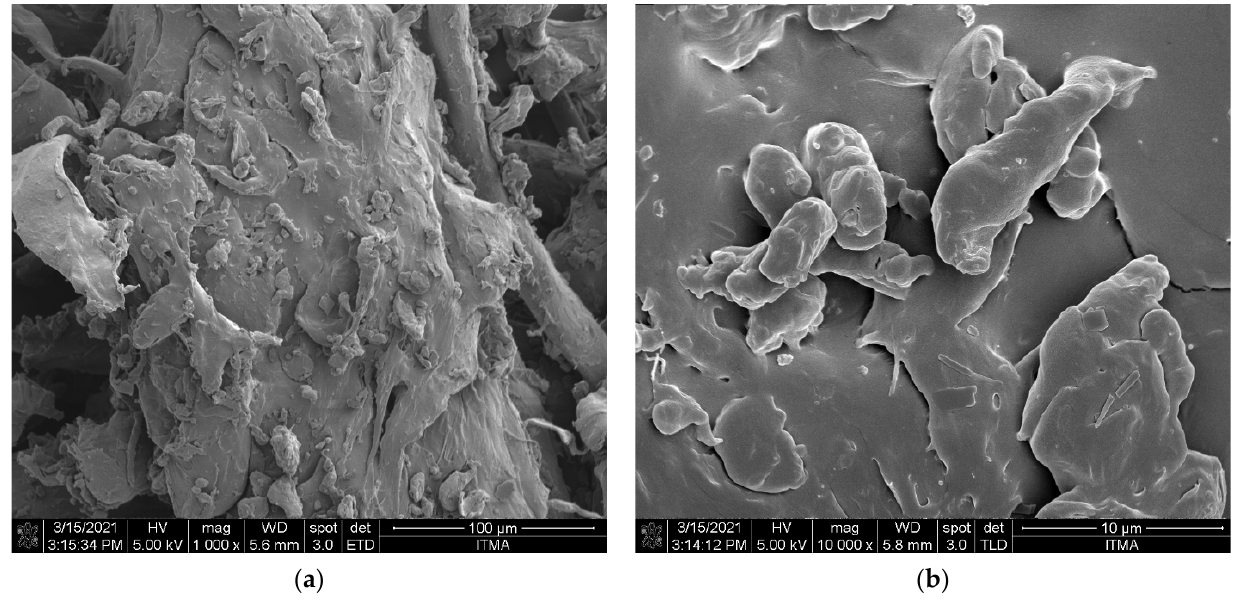
Figure 3. FESEM images of PP-IG samples at magnifications of ( a ) 1 kx and ( b ) 10 kx.